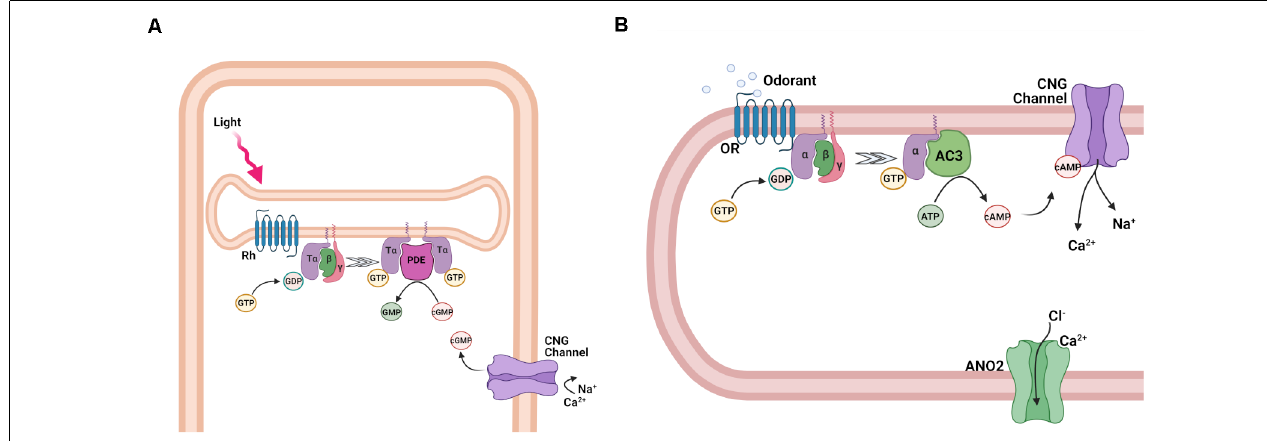
FIGURE 4 | Activation of the transduction cascade in rod photoreceptors and OSNs. (A) Schematic representation of phototransduction cascade in rods. Abbreviations: rhodopsin (Rh), T α , β , and γ subunits of the retinal G protein, transducin (T), guanosine-5 (cid:48) -triphosphate (GTP), guanosine-5 (cid:48) -diphosphate (GDP), phosphodiesterase (PDE), guanosine monophosphate (GMP), and cyclic guanosine monophosphate (cGMP), and cyclic nucleotide-gated (CNG) channel. (B) Schematic representation of the olfactory transduction cascade in OSNs. Abbreviations: Olfactory receptor (OR), guanosine-5 (cid:48) -triphosphate (GTP), guanosine-5 (cid:48) -diphosphate (GDP), G α olf , β , and γ , subunits of the olfactory G protein; adenylyl cyclase 3 (AC3), adenosine-5 (cid:48) -triphosphate (ATP), cyclic adenosine monophosphate (cAMP), cyclic nucleotide-gated (CNG) channel; Ca 2+ -activated Cl − channel anoctamin 2 (ANO2). Images created with BioRender.com.